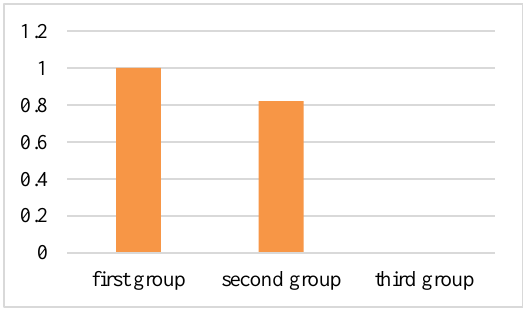
Figure 6. The surprise mode in autistic